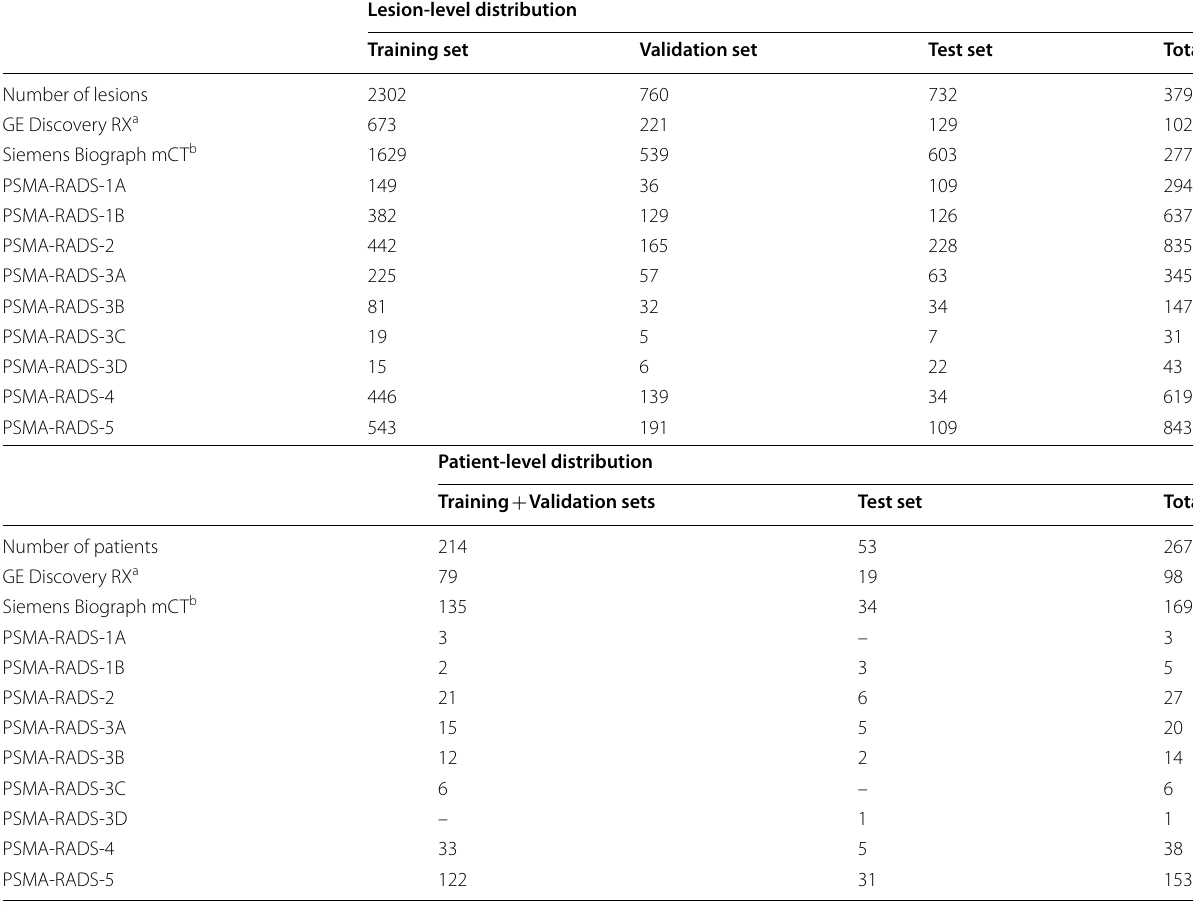
Table 1 Dataset